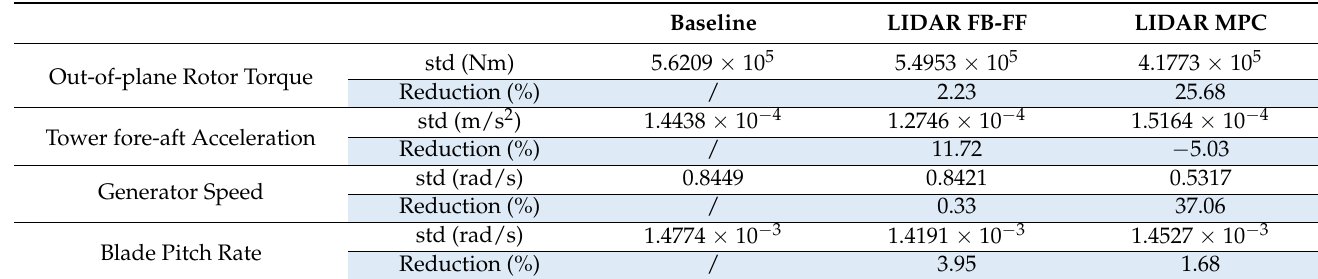
Table 3. Performance statistics for a wind speed with 5% turbulence